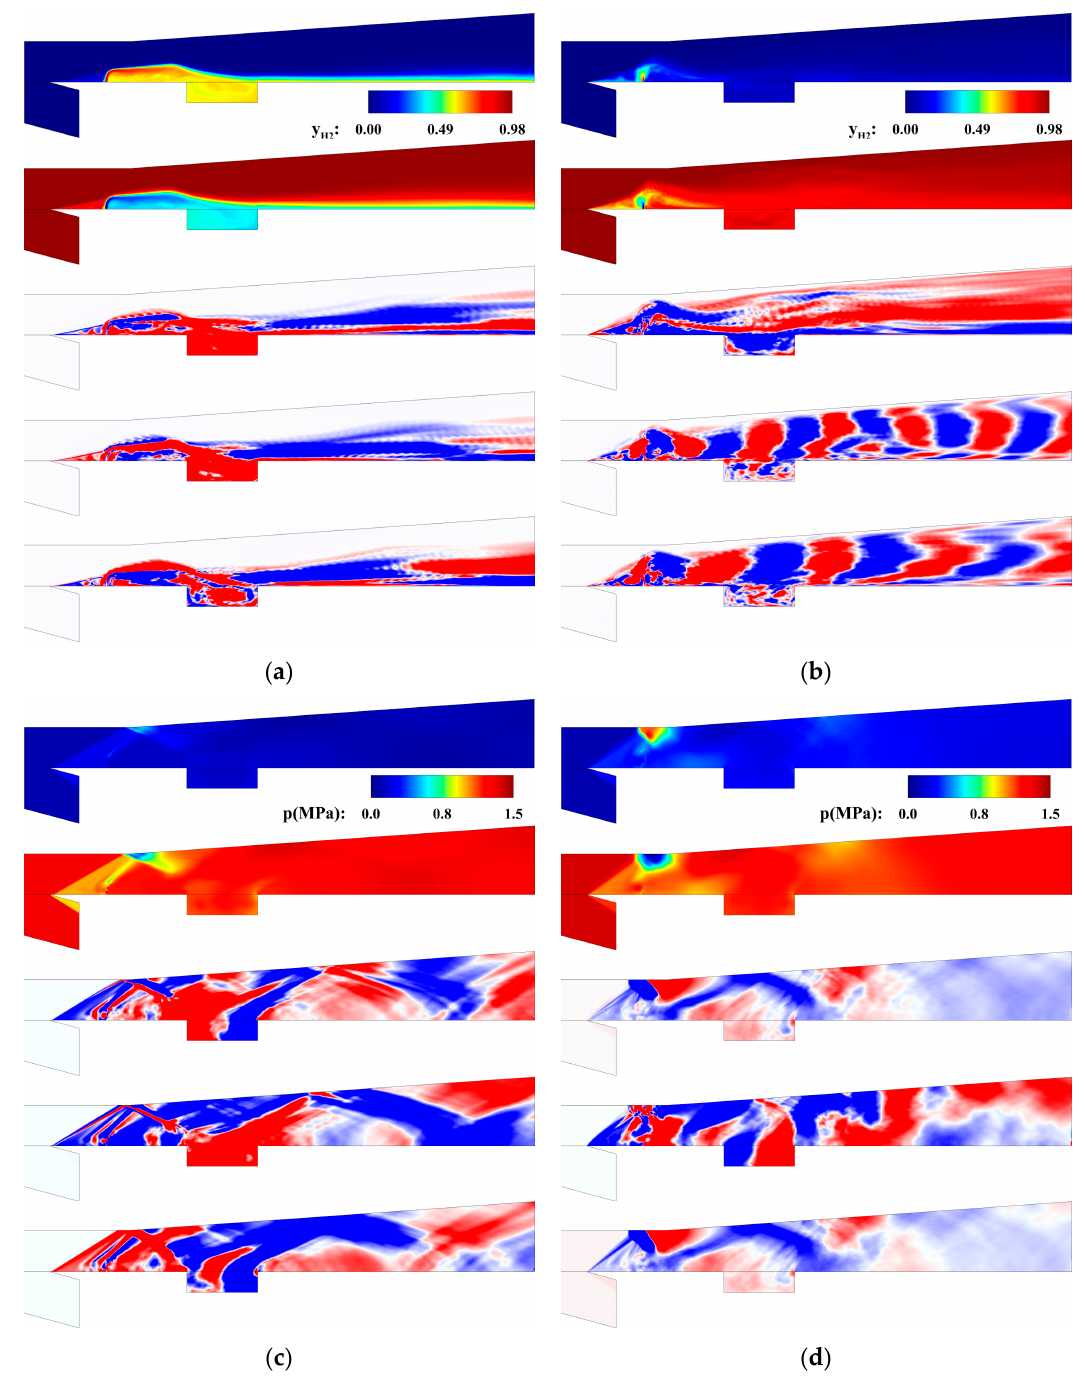
Figure 8. (In order from top to bottom) time-averaged results of the numerical experiments, mean mode, 1st mode, 2nd mode, 3rd mode of the DMD: H 2 mass fraction at ( a ) 0.75 MPa and ( b ) 1.00 MPa; pressure distribution at ( c ) 0.75 MPa and ( d ) 1.0 MPa.